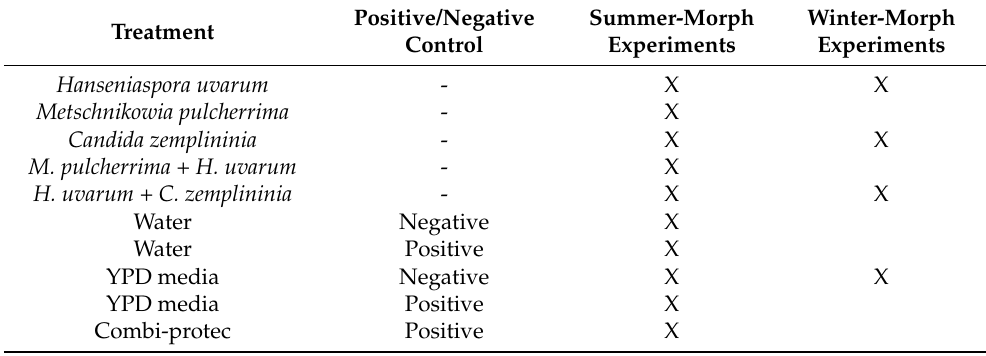
Table 1. Single and fermented combinations of yeasts tested as baits with winter- and summer-morph Drosophila suzukii . Yeasts were compared to water or yeast peptone dextrose media (YPD; 1% yeast extract, 2% peptone, and 2% dextrose) controls with (positive) or without (negative) insecticides. A commercial product Combi-protec was included as a second positive control for summer-morphs experiments. X denotes which treatments were included in each experiment. Positive/Negative Summer-Morph Winter-Morph Treatment Control Experiments